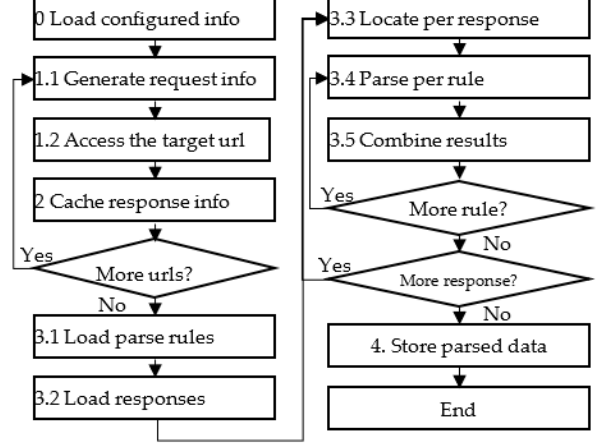
Figure 2. The final algorithmic design of the Crawler Service.